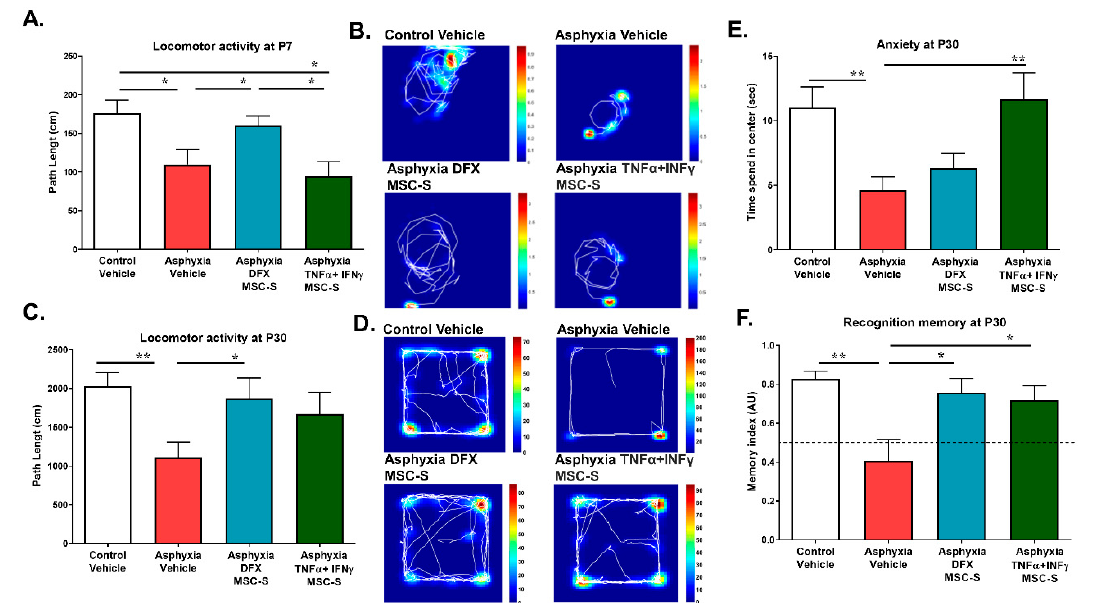
Figure 8. Effect of intranasal administration of DFX- or TNF- α +IFN- γ -MSC-S on locomotor activity, anxiety, and recognition memory. Locomotor activity: exploratory behavior was monitored in a square open field arena at P7 and P30. ( A ) Locomotor activity at P7. Data represent means ± SEM. Kruskal-Wallis, * p < 0.05, followed by Benjamini, Hochberg, and Yekutieli post-hoc: * p < 0.05 , Control vehicle (CS, white bar) v/s Asphyxia vehicle (AS, red bar ), * p < 0.05; CS v/s Asphyxia-TNF α +IFN- γ -MSC-S (green bar), * p < 0.05; AS v/s Asphyxia-DFX-MSC-S (cyan bar), * p < 0.05; Asphyxia-DFX-MSC-S v/s Asphyxia-TNF α +IFN- γ -MSC-S, N = 8 – 10 samples per group. ( C ) Similar effects on locomotor activity were observed at P30: Kruskal-Wallis, * p < 0.05, followed by Benjamini, Hochberg, and Yekutieli post-hoc: * p < 0.005, CS v/s AS; * p < 0.05, AS v/s Asphyxia-DFX-MSC-S), N = 8–12 samples per group. Representative tracking traces showing the occupancy maps of different groups of rats in the arena at P7: ( B ); and at P30: ( D ) The color bars represent the time of occupancy and the solid line the trajectory travelled. ( E ) Anxiety at P30. Quantification of the time spent by the rats at the center of the arena was monitored during a first 5 min observation period. AS rats remained close to the wall of the arena, avoiding the center and other areas devoid of thigmotactic cues. This behavior was reversed by TNF α +IFN- γ -MSC-S administration. Data represent means ± SEM. Kruskal-Wallis test, ** p < 0.005, followed by Benjamini, Hochberg, and Yekutieli post-hoc: ** p < 0.005; CS v/s AS , ** p < 0.005; AS v/s Asphyxia-TNF α +IFN- γ -MSC-S, N = 8 – 12 samples per group. ( F ) Novel object recognition memory at P30. First, the rat was exposed to two identical objects for 5 min. 24 h later, the rat was exposed to one of the same objects and to a new object. Memory index refers to the time spent exploring the new object divided by the total time spent exploring the old and the new object. Values of memory index equal to or below 0.5 indicate memory deficit. Data represent means ± SEM. Kruskal- Wallis test * p < 0.05 , followed by Benjamini, Hochberg, and Yekutieli post-hoc: ** p < 0.005, CS (white bar) v/s AS (red bar), * p < 0.05; AS v/s Asphyxia-DFX-MSC-S (cyan bar); * p < 0.05, AS v/s Asphyxia-